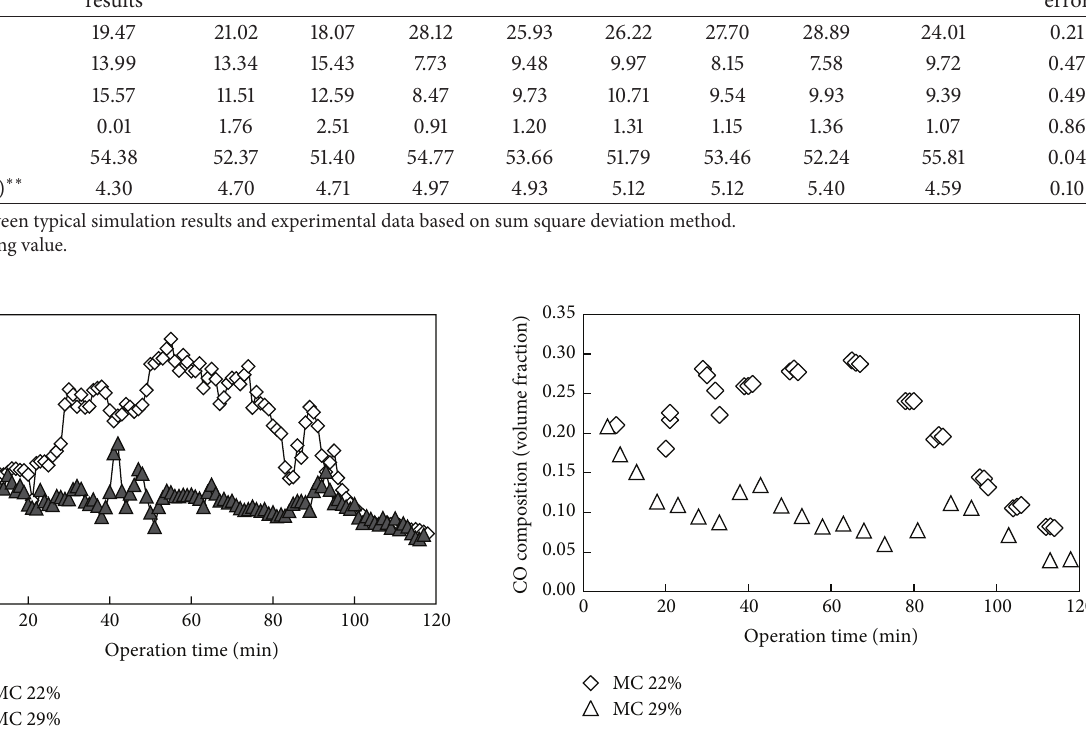
Figure 3: Carbon monoxide content in syngas over operation time for fuel of different initial moisture